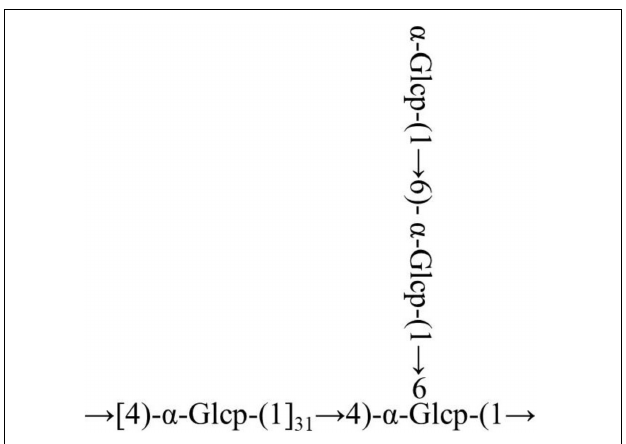
FIGURE 5 | Putative structure of RATAPW.